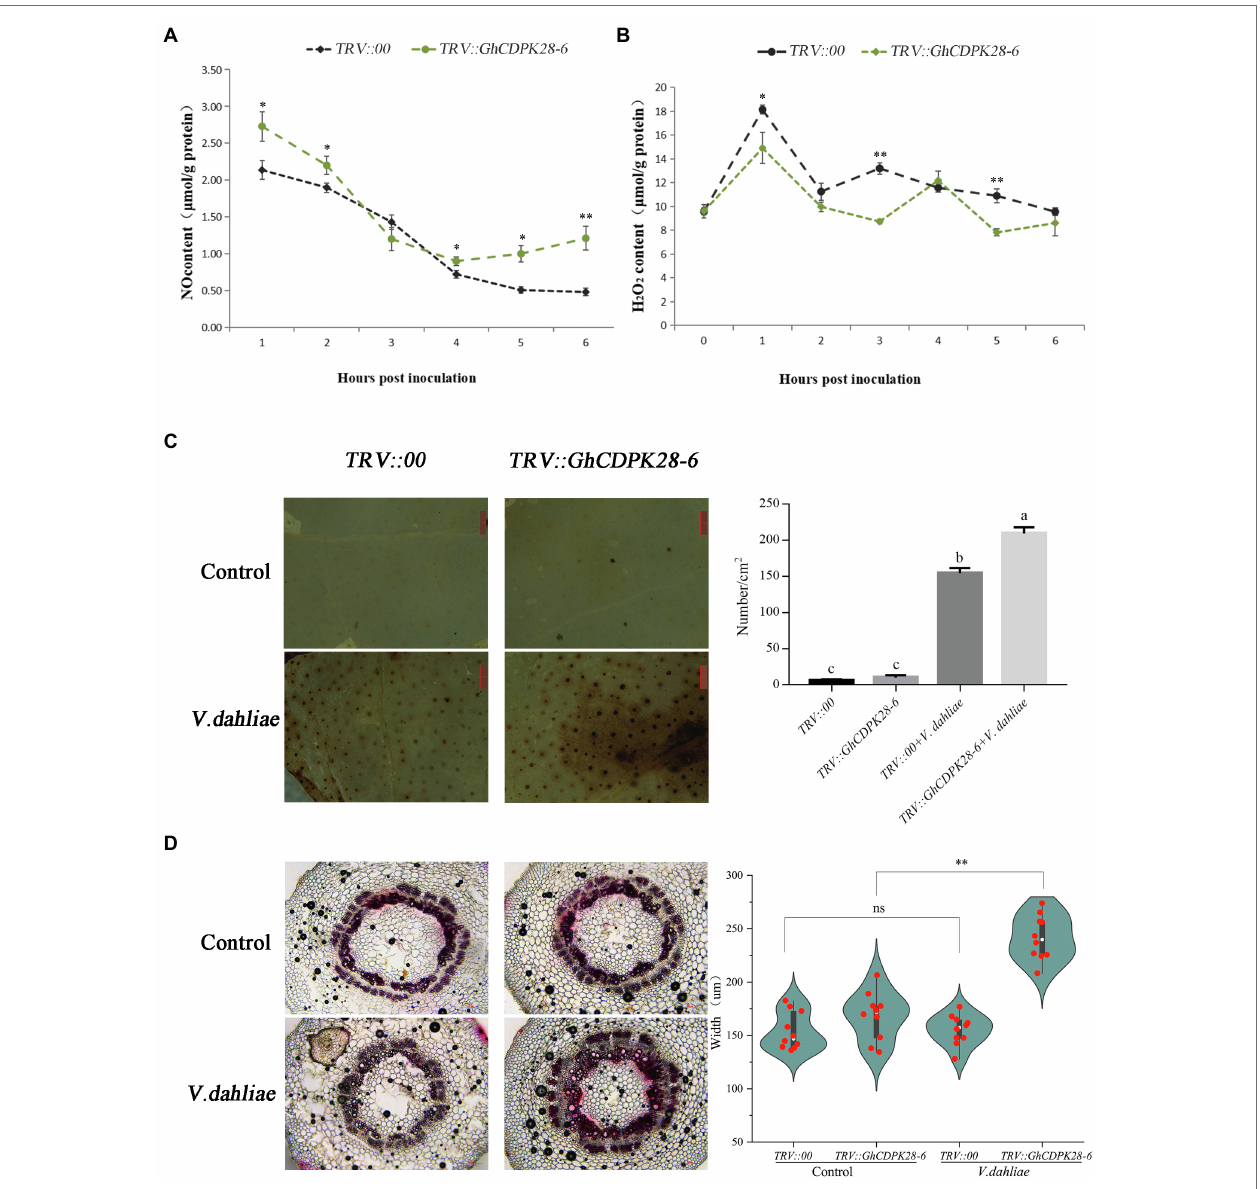
FIGURE 7 | Accumulation of NO and H 2 O 2 , phenotypes of reactive oxygen species bursts and lignin deposition in GhCDPK28-6 silenced and control plants. (A) NO content in roots of silenced plants and control plants within 6 h after V. dahliae inoculation. (B) H 2 O 2 content in roots of silenced plants and control plants within 6 h after V. dahliae inoculation. (C) Production and accumulation of ROS in cotton leaves after 12 h of V. dahliae inoculation, and quantitative analysis of ROS. DAB staining was used for detection. It was observed under the stereomicroscope with 10× amplification and the number of stained spots per cm 2 was recorded. The scale is 1 mm. (D) After 72 h of inoculation, cotton vascular bundles were stained with phloroglucinol and their widths were recorded. The scale is 200 μ m. The experiment was repeated three times (* p < 0.05; ** p < 0.001, Student’s t